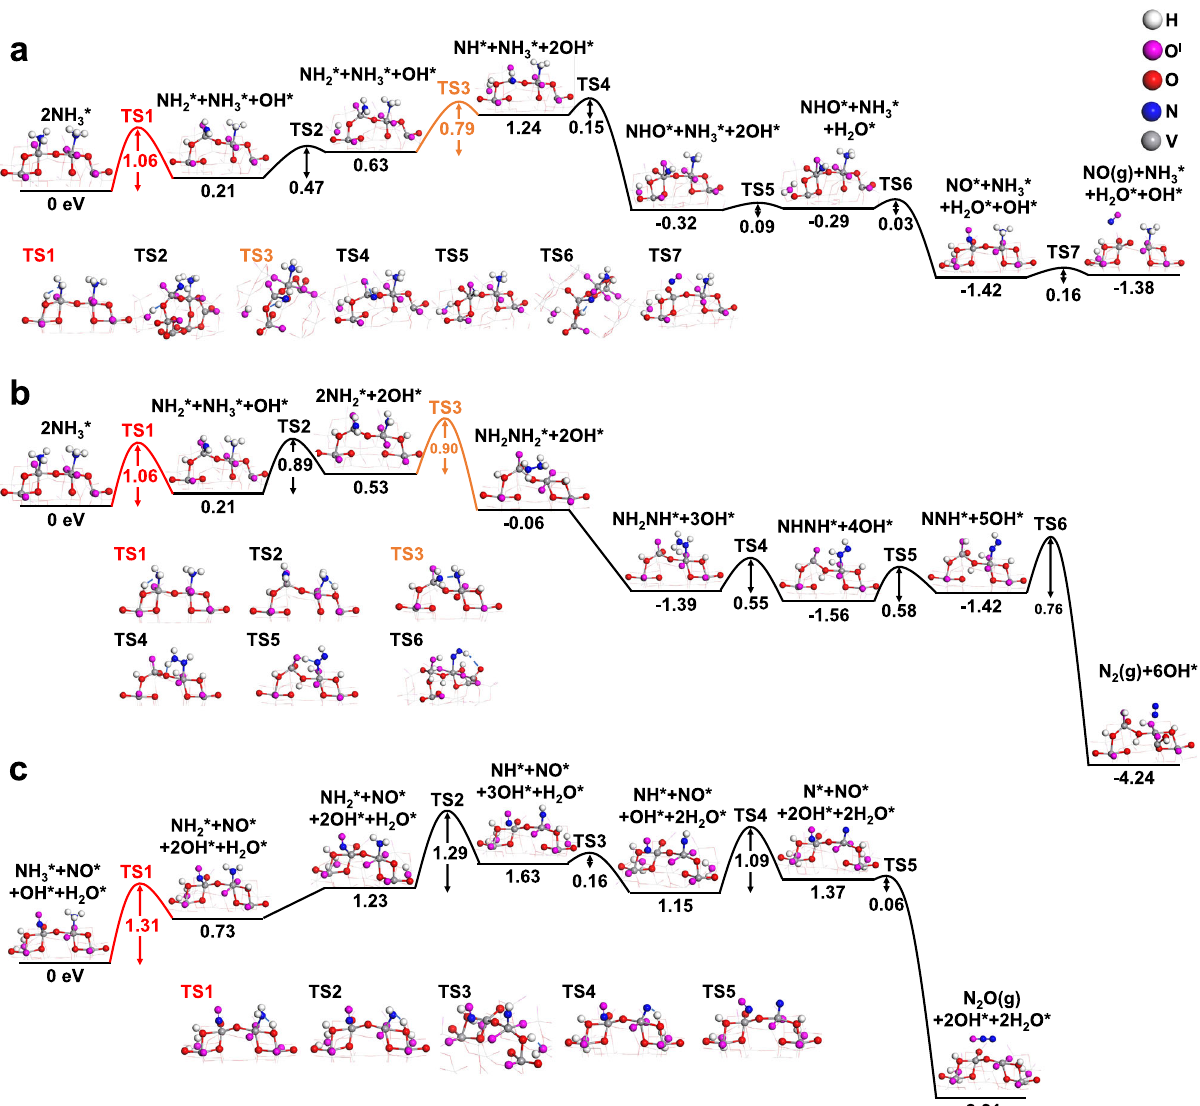
Fig. 6 DFT calculations of CLAO paths on V 2 O 5 . Computed energy potential pro fi les of each elementary step for the formation of a NO, b N 2 and c N 2 O on V 2 O 5 (001) surface. The kinetic barrier of each elementary step is given in